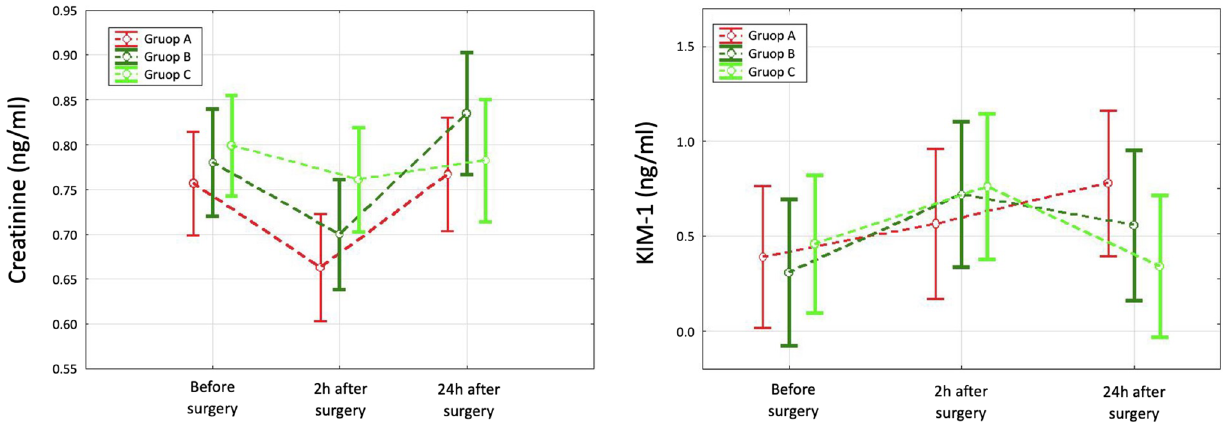
Figure 3. Creatinine and KIM-1 levels before and 2 h and 24 h after